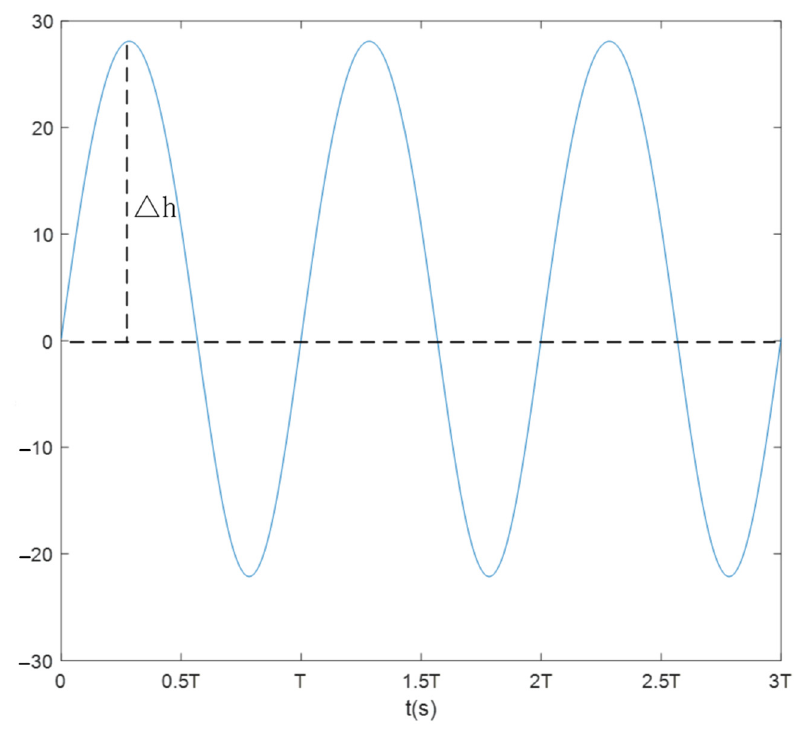
Figure 10. Height fluctuation curve of fuselage centroid relative to the centroid of the whole machine system.